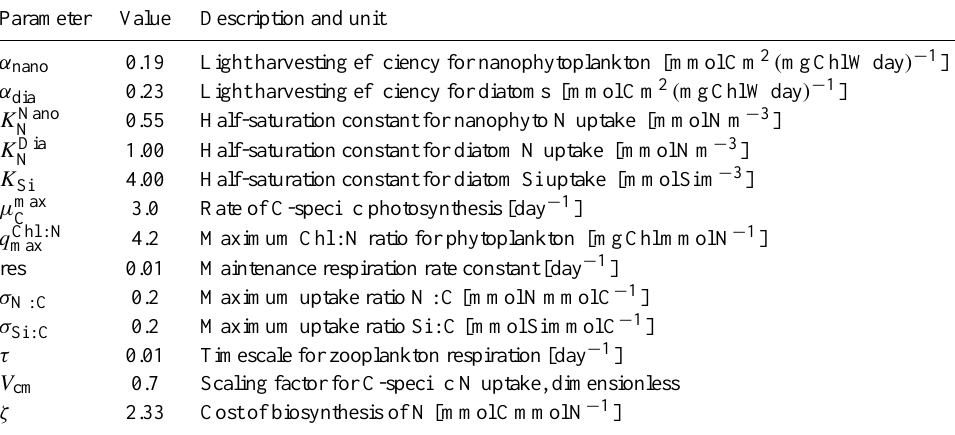
Table A8. Parameters for phytoplankton